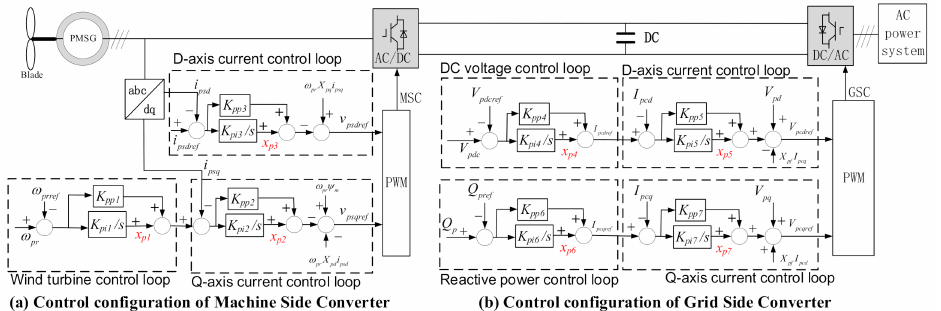
Figure 1. Physical configuration of an FCWG connected to the AC power system.